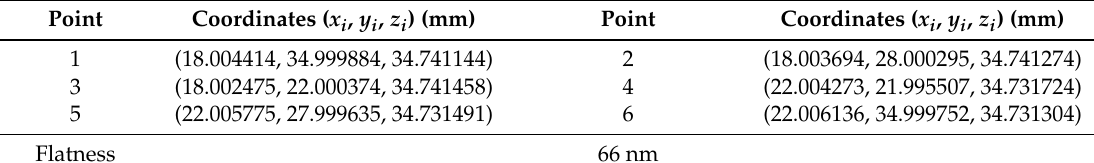
Table 1. Obtained coordinates of 6 points on the measuring surface of a gauge block and flatness.